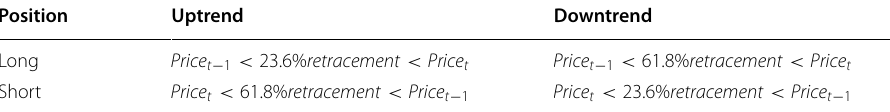
Table 3 Summary of retracement levels Position